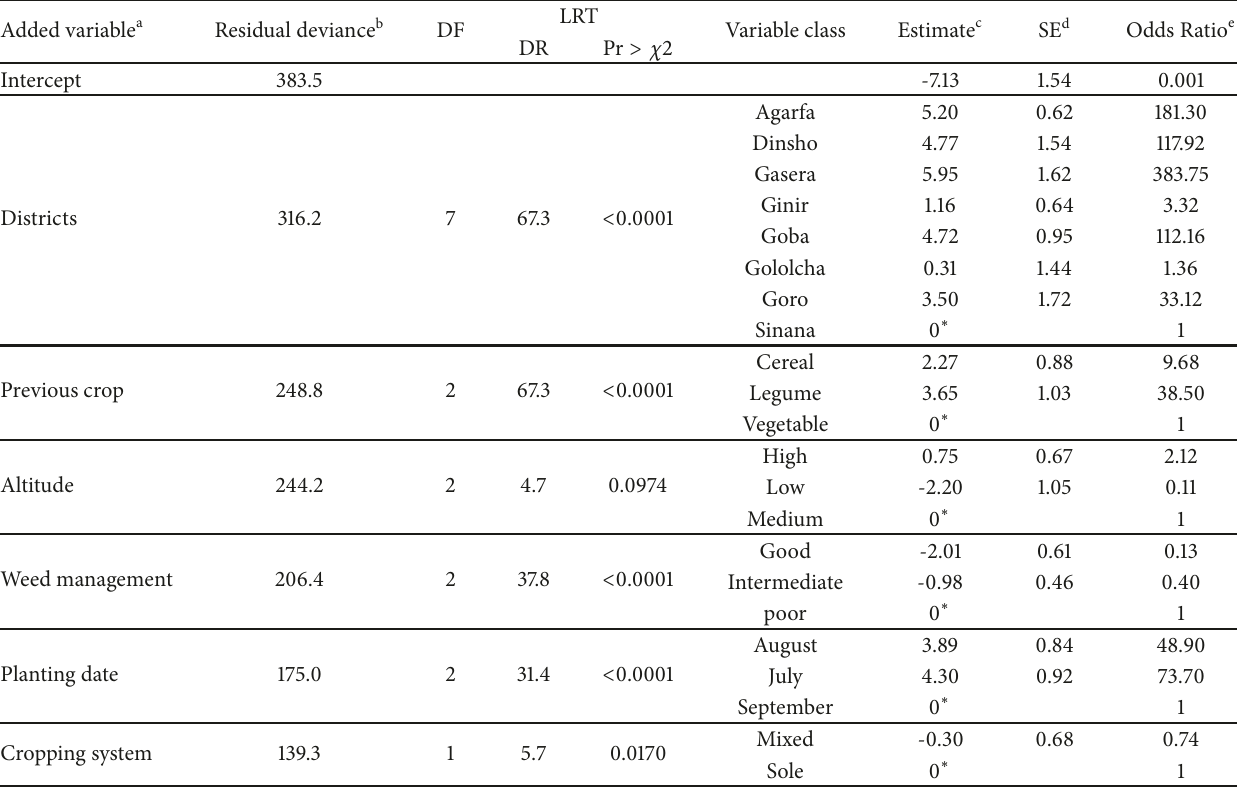
Table 6: Analysis of deviance, naturallogarithms of odds ratio, and standard error of added variables in a reduced model analyzing chocolate spot percentage severity index (PSI).